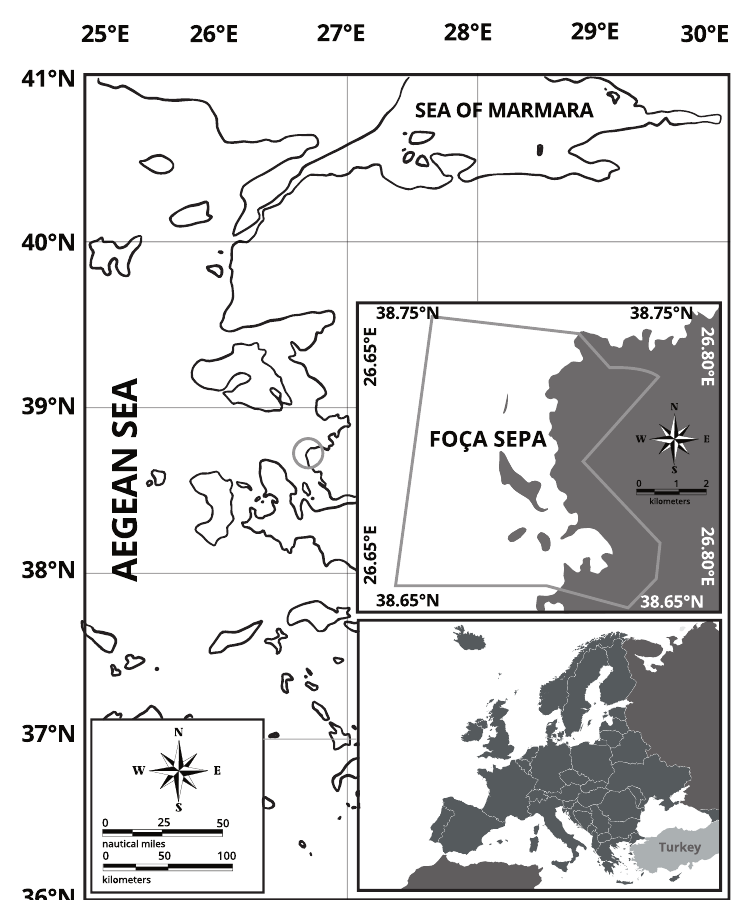
Fig. 1. The study area (Foça SEPA, Aegean Sea, Turkey)